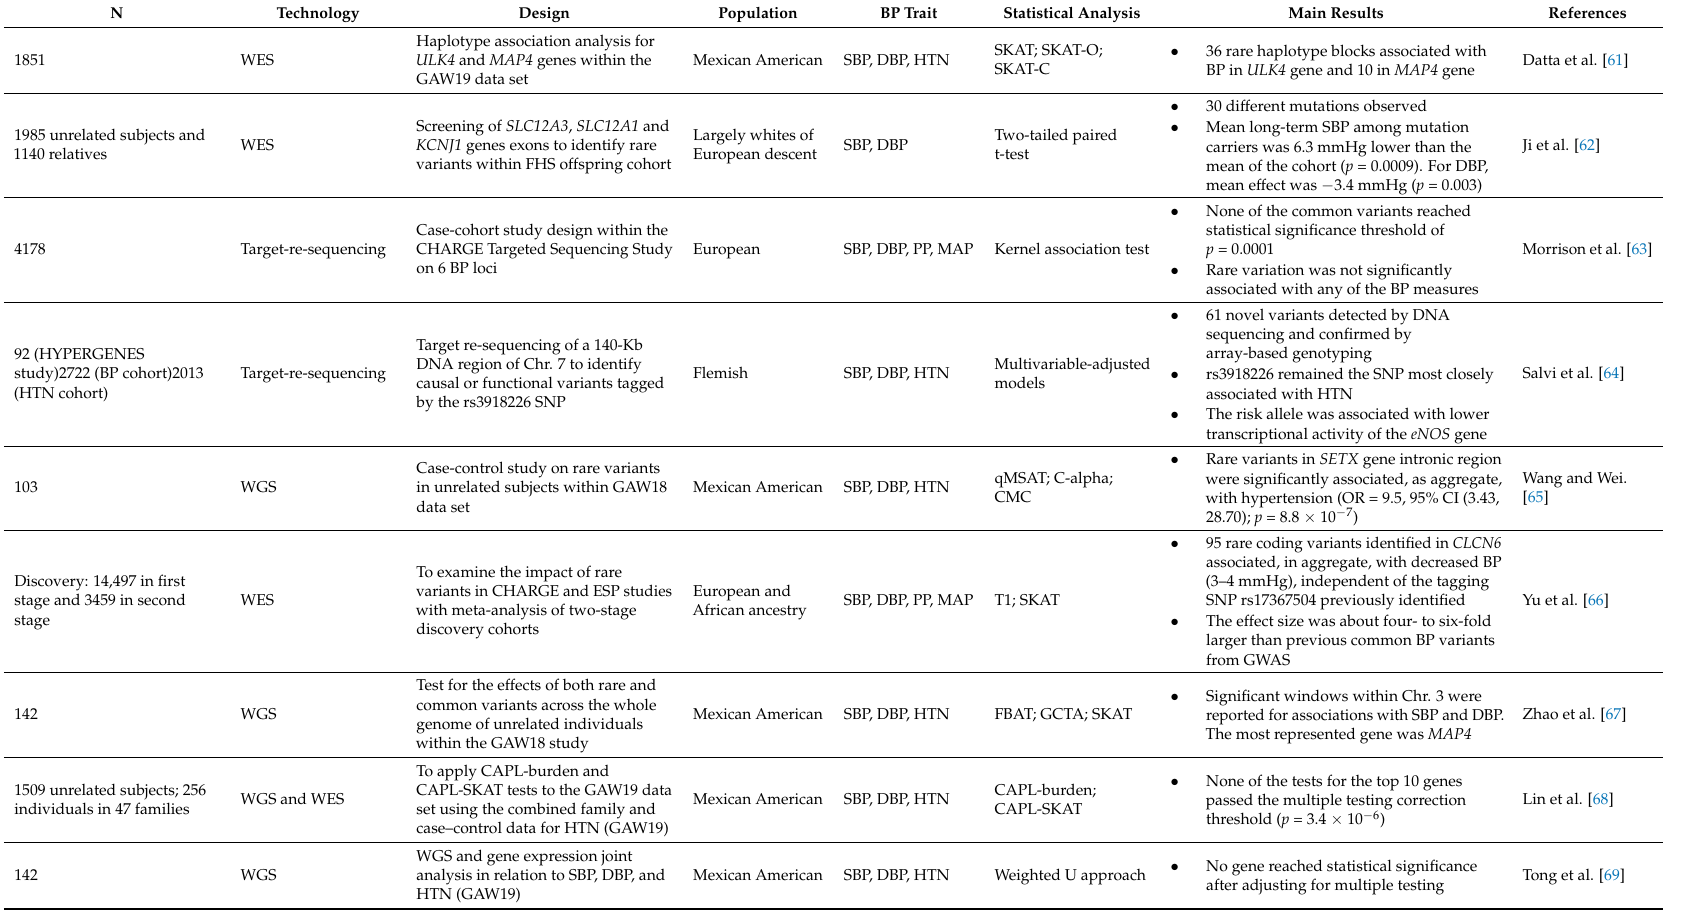
Table 2. Results from Next-Generation Sequencing